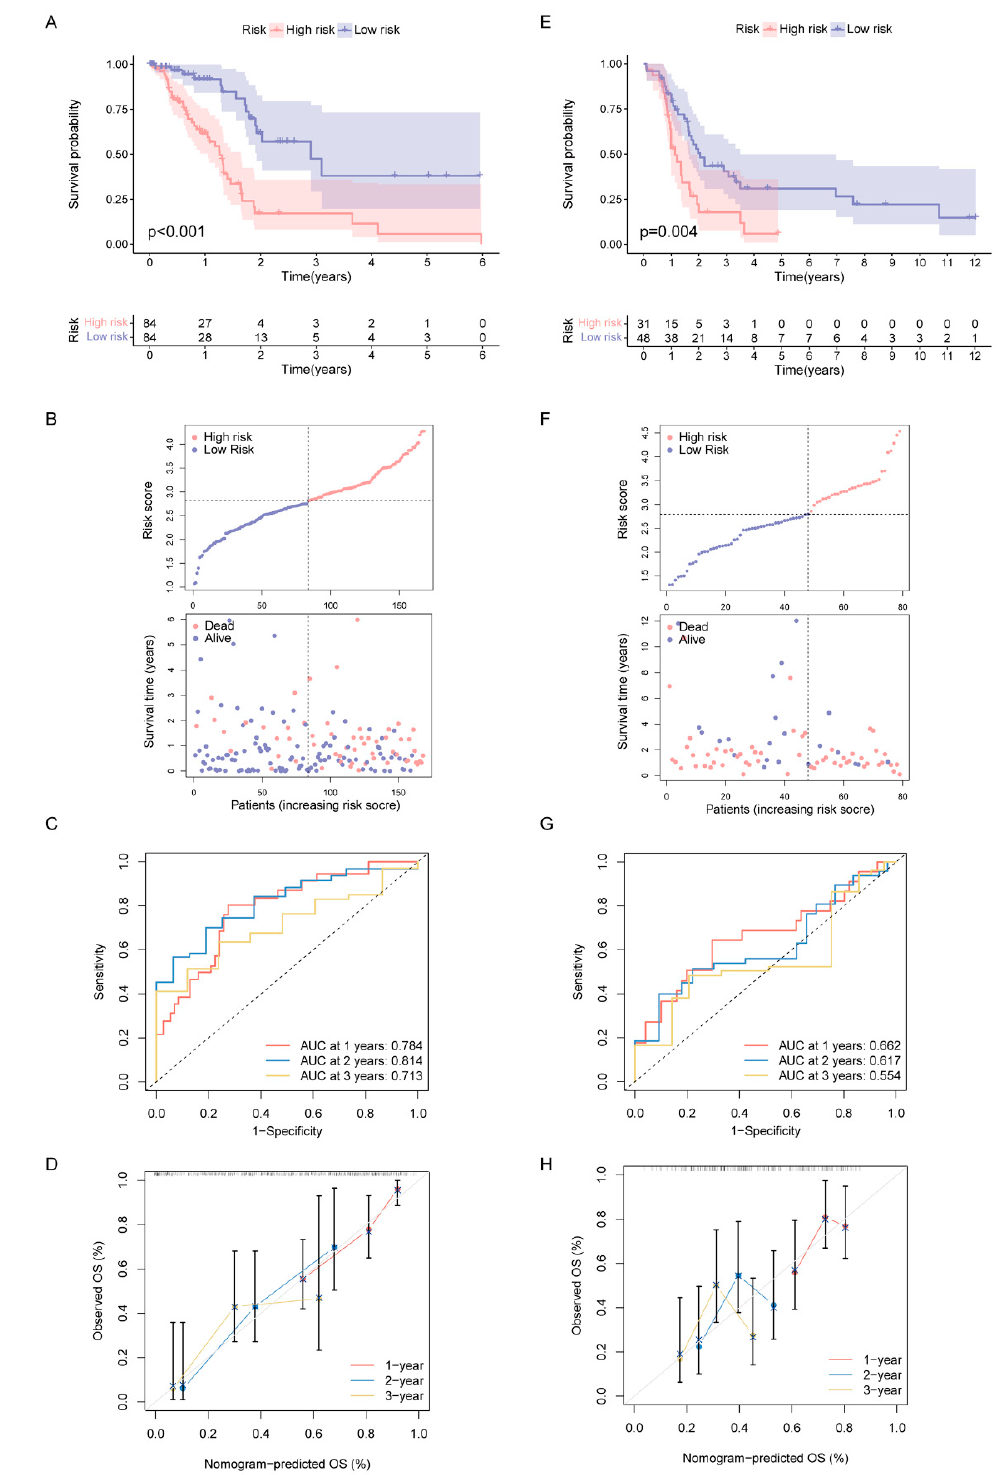
Figure 6. Construction and validation of DDR- and immune-based risk score (DPRS) model. ( A – D ) Construction and validation of TCGA training set. ( A ) The OS of training set. ( B ) Distribution of DPRS and OS of training set. Time-dependent ROC curves ( C ) and calibration curves ( D ) validation at 1, 2, and 3 years of prognostic value in TCGA cohort. ( E – H ) Construction and validation of GEO external validation set (GSE85916). ( E ) The OS of validation set. ( F ) Distribution of DPRS and OS of validation set. Time-dependent ROC curves ( G ) and calibration curves ( H ) validation at 1, 2, and 3 years of prognostic value in GEO cohort.